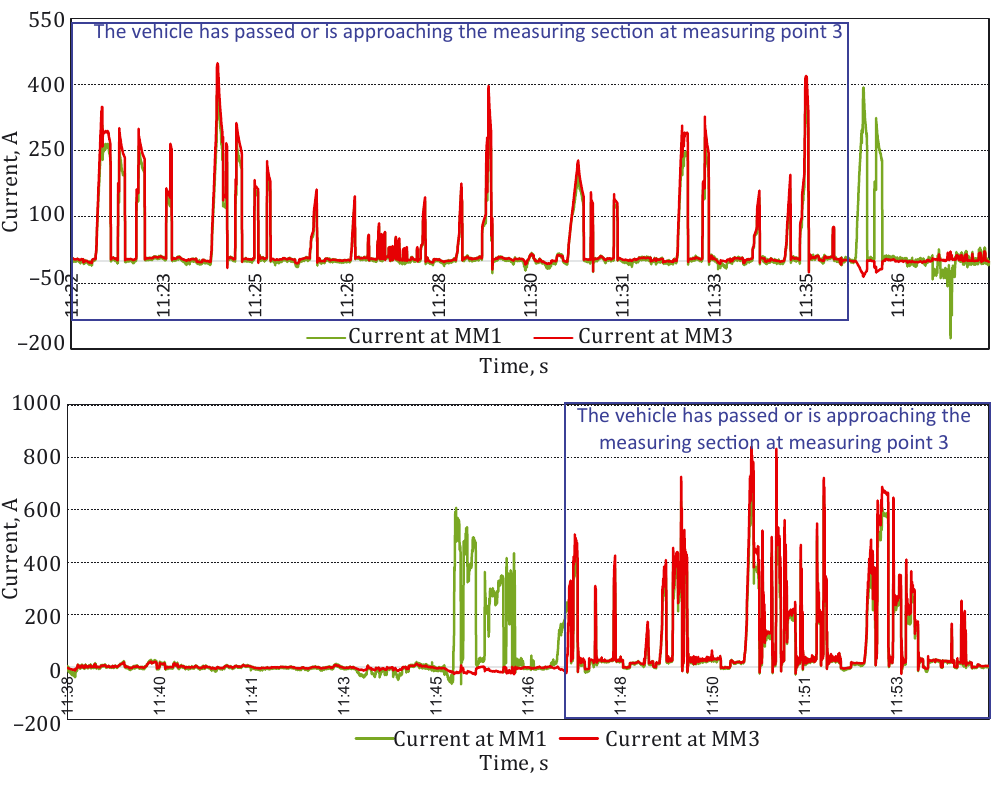
Figure 11. Distribution of current in rails at the measuring points 1 and